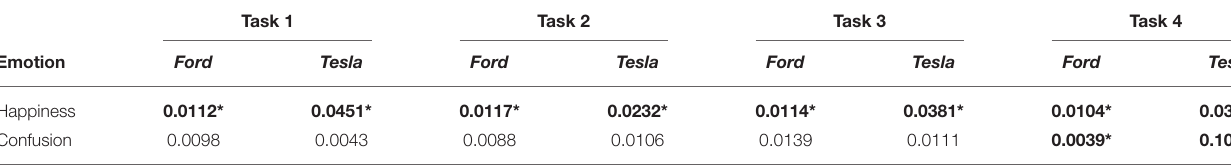
TABLE 1 | The average values for Happiness and Confusion for both groups (Ford and Tesla) during the four navigation tasks.